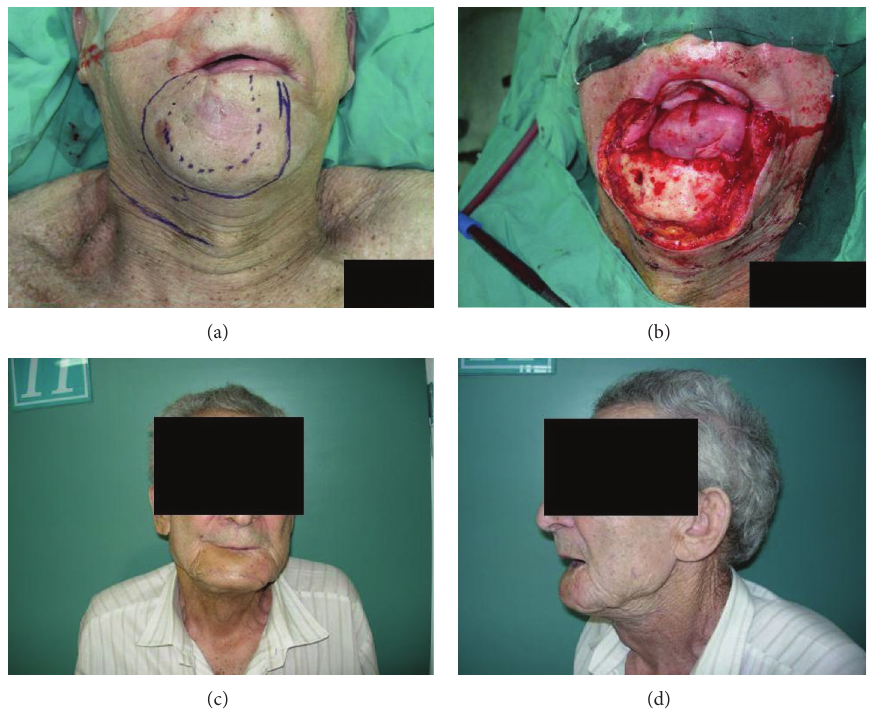
Figure 4: Patient number 1. (a) Preoperative marking. Tumor border (dashed line) planed resection (continuous line). (b) Intraoperative defect showing 80% thru en thru lower lip defect and chin defect with exposed mandible. ((c), (d)) Postoperative result.